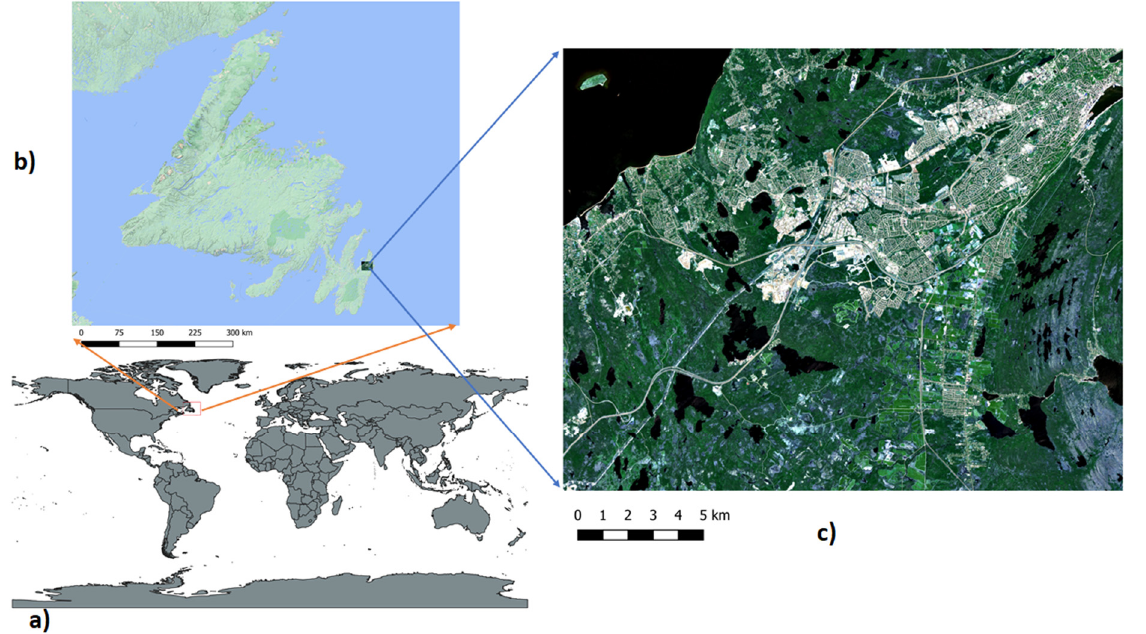
Figure 1. The study area of the Avalon located in Newfoundland, Canada, ( a ) location of Newfoundland in the world map (bottom left image), ( b ) location of the Avalon study area with respect to the Newfoundland (top left image), and ( c ) Sentinel-2 true-color map of the study area (right image).